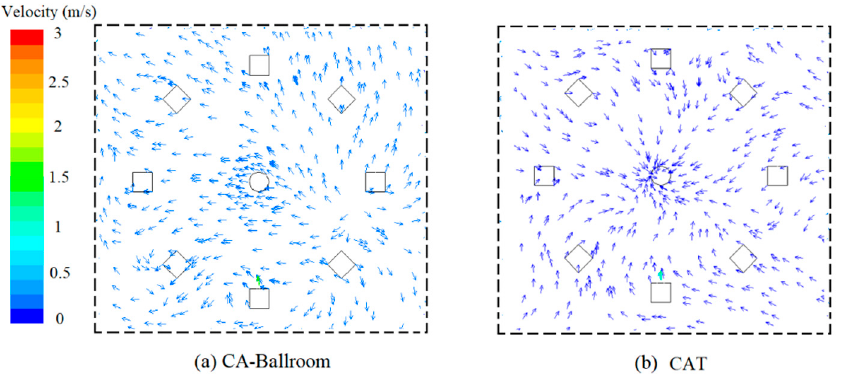
Figure 11. The velocity vector of airflow at the height of the breathing zone (Z = 1.1 m) at the table with the infector under two ventilation conditions.